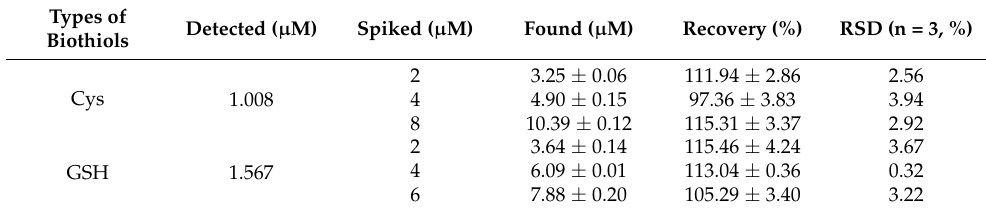
Table 2. The recovery of Cys and GSH molecules detection in real samples. Types of Biothiols